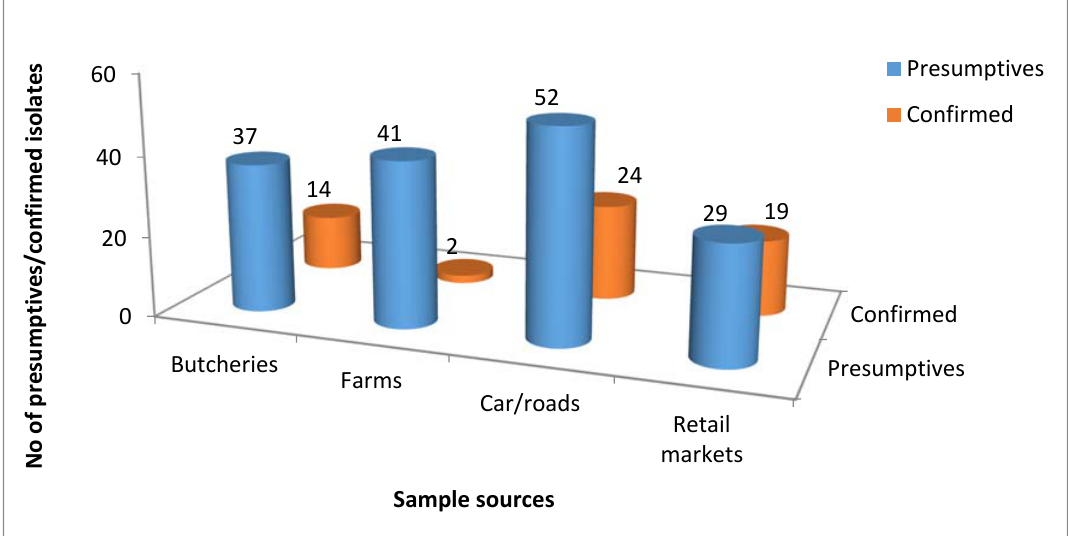
Figure 1. A pictorial representation of presumptive/confirmed Campylobacter isolates recovered from milk samples from different sources.